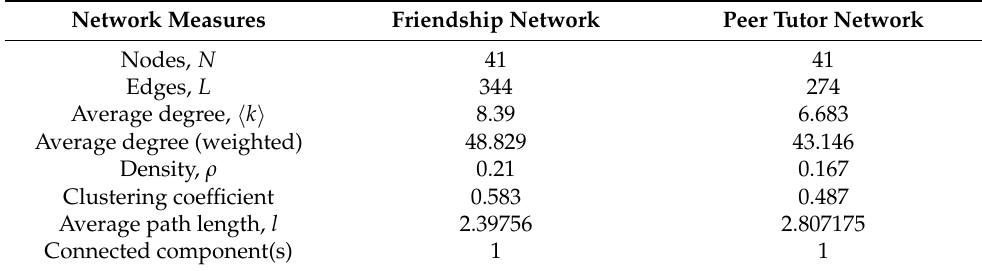
Table 1. Topological summary of friendship and peer tutor